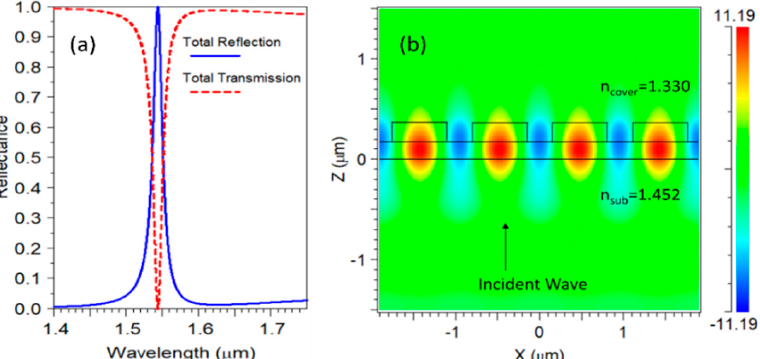
Figure 1. RCWA results for the 2D RWG. ( a ) Reflection (solid blue) and transmission (dashed red) spectra; ( b ) Electric field component Ey at the resonant wavelength of 1543.8 nm (normalized to the incident